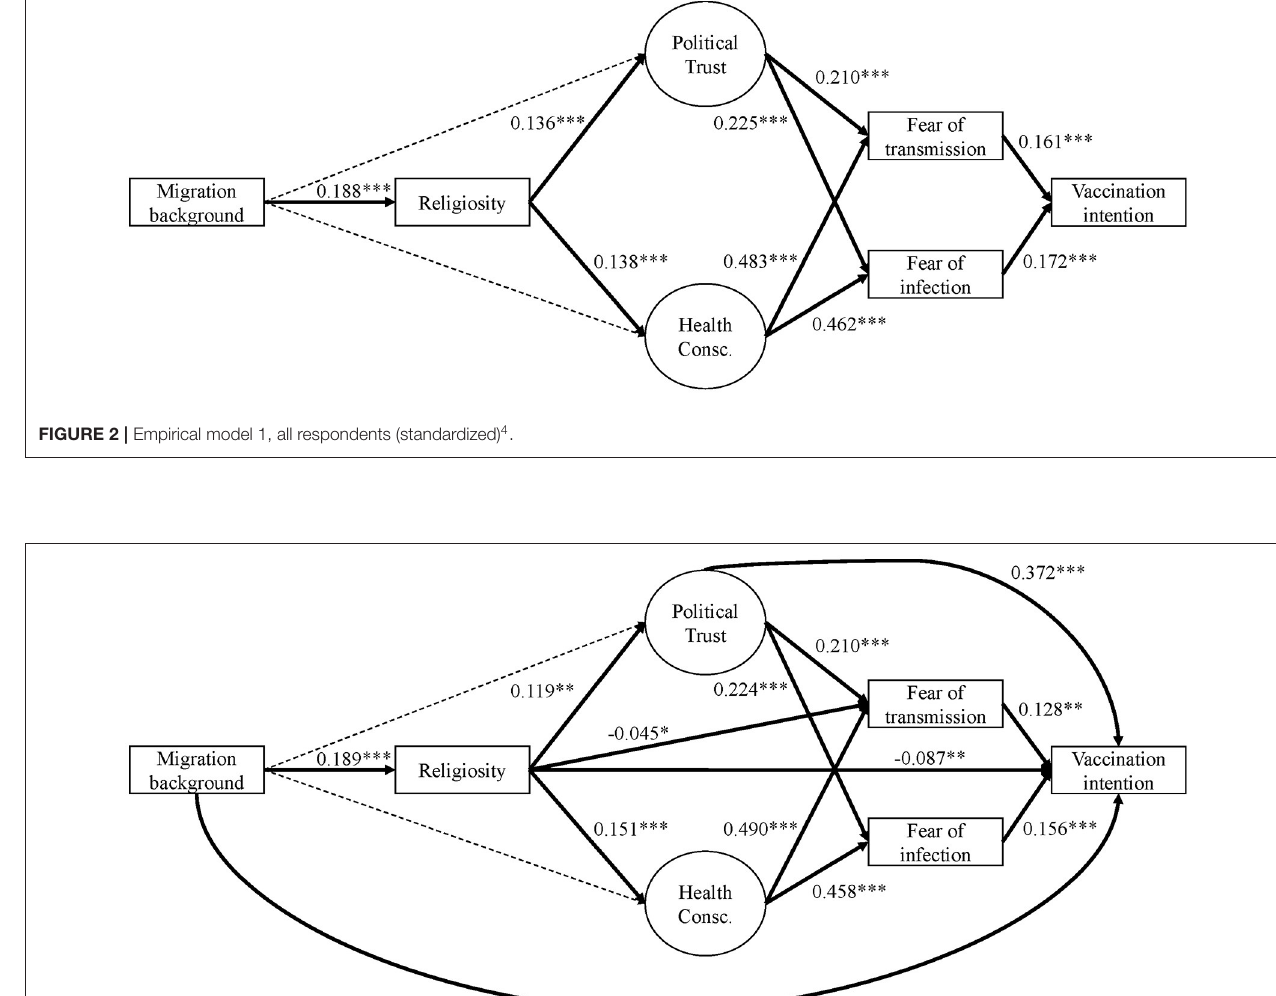
Political Trust and Health